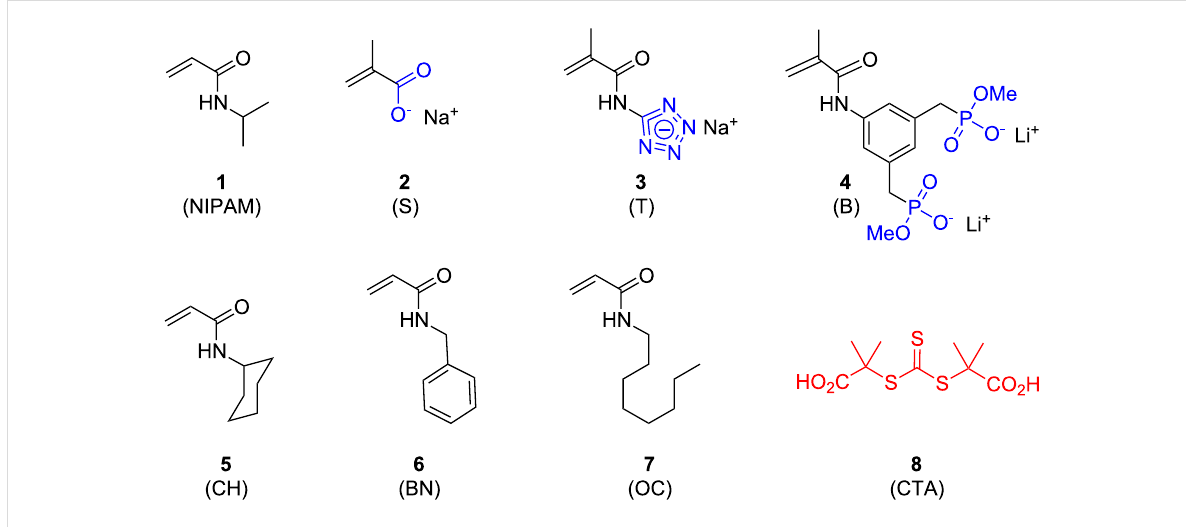
Figure 1: Structures of monomers 1 – 7 and chain transfer agent 8 used in the RAFT polymerizations.